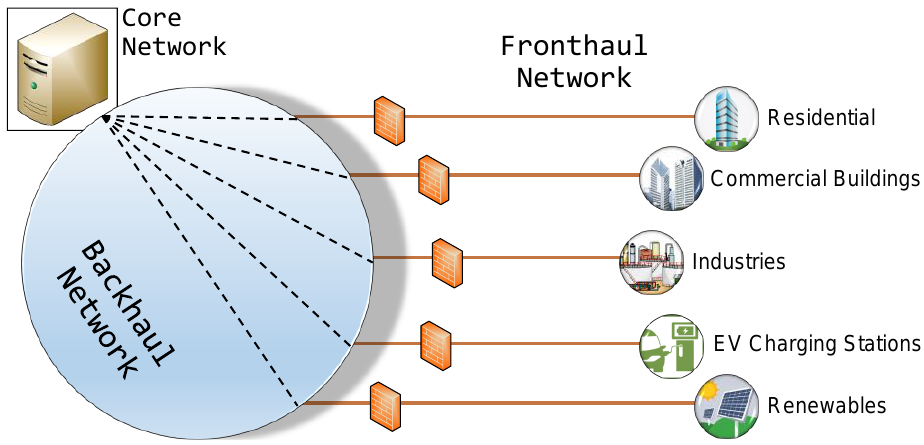
Figure 6. Typical connectivity scenario in the smart grid network.